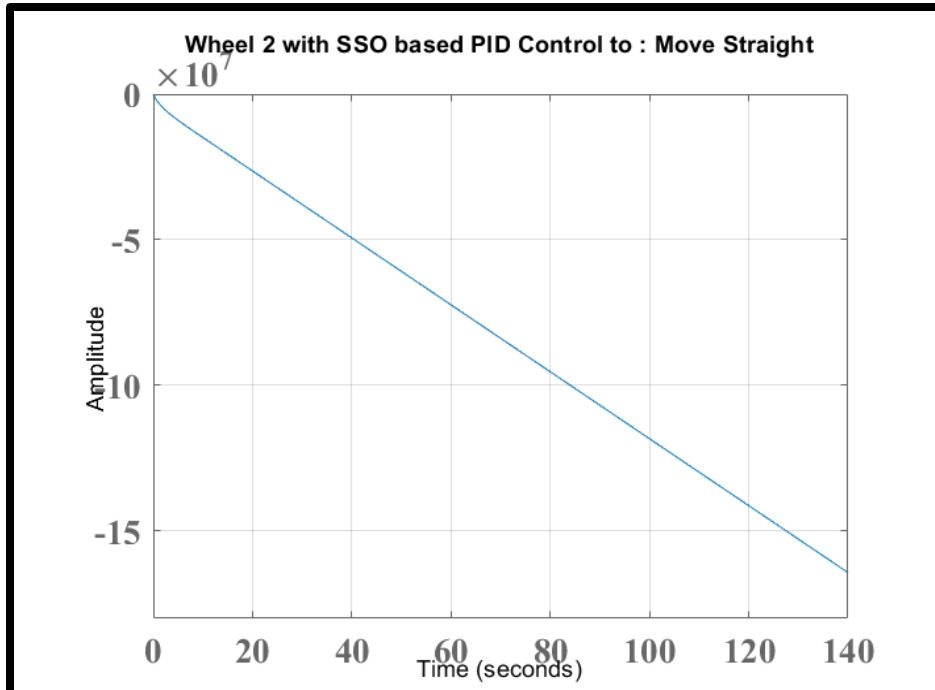
Figure 11. Simulation of wheel 1 moving forward when V r = − V L .